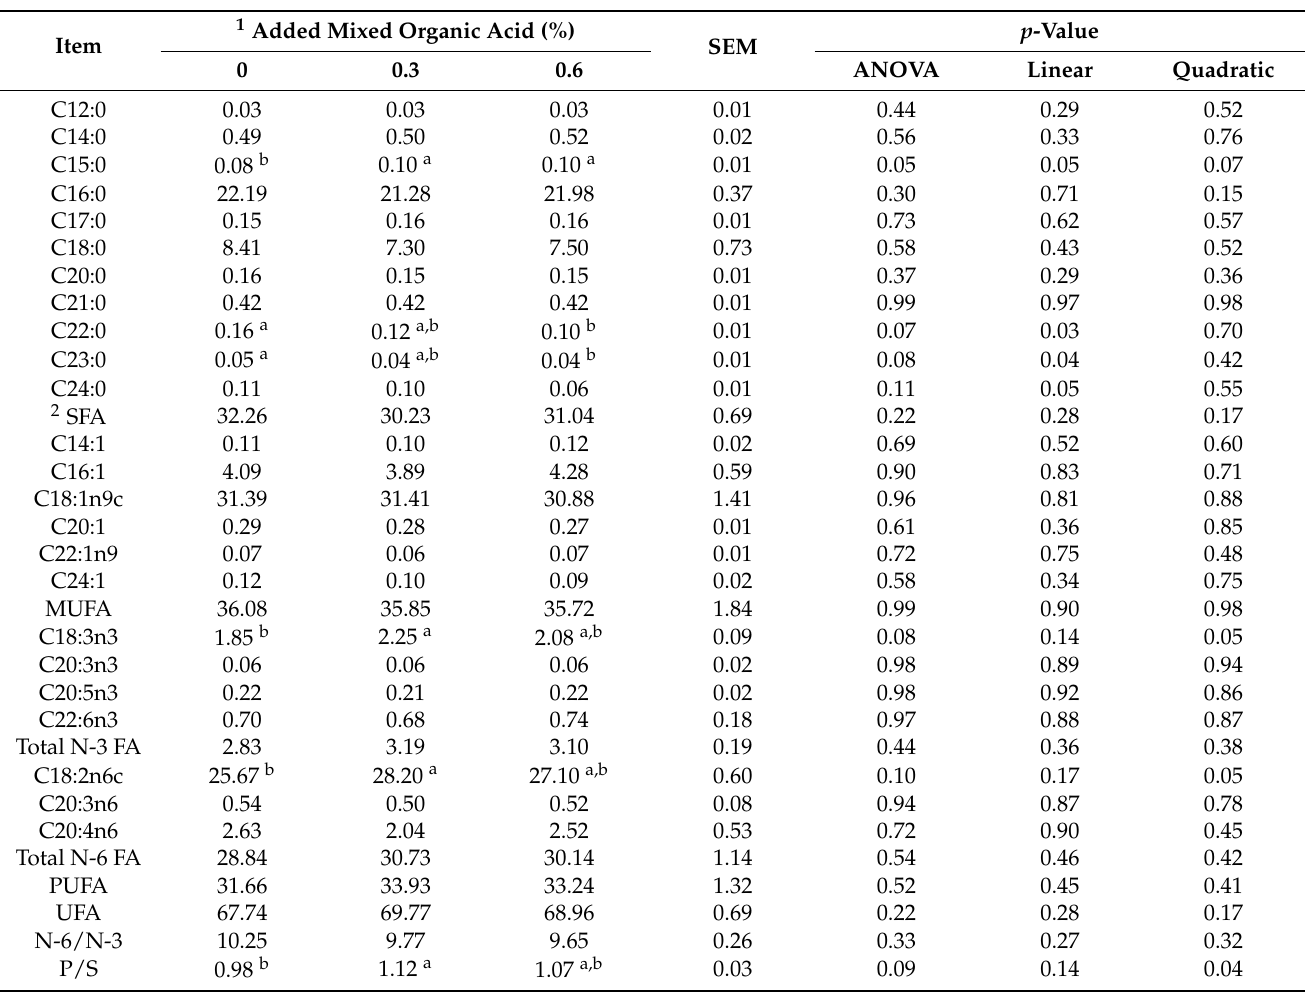
Table 5. Fatty acids composition in thigh muscle of broiler chickens as affected by dietary MOA supplementation (g/100 g total fatty acids,